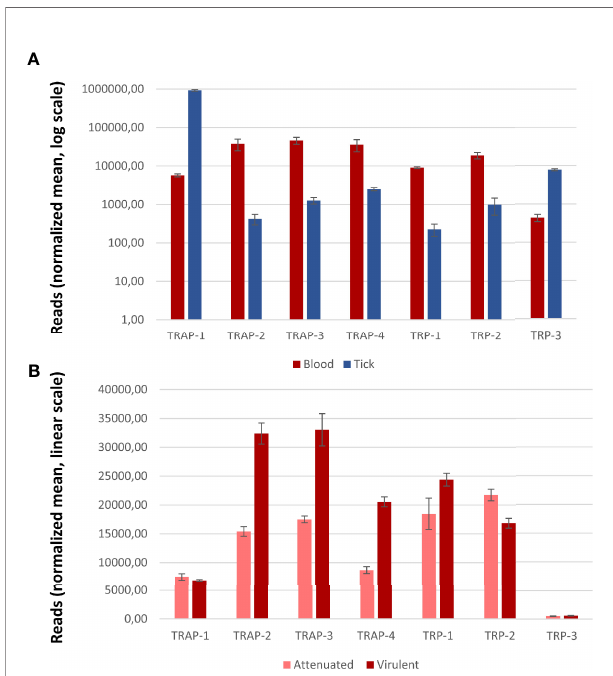
FIGURE 4 | Transcription of Babesia bovis genes coding for TRAP- and TRP- family proteins. (A) Transcription patterns from blood and tick stages (normalized reads, log scale). (B) Transcription patterns from virulent and attenuated strains (normalized reads, linear scale). Gene transcription was considered signi fi cantly and differentially regulated if |log fold change (FC)| ≥ 1 and false detection rate (FDR) < 5%. Error bars represent S.D. Signi fi cant differences were obtained for all genes except for TRAP-1 and